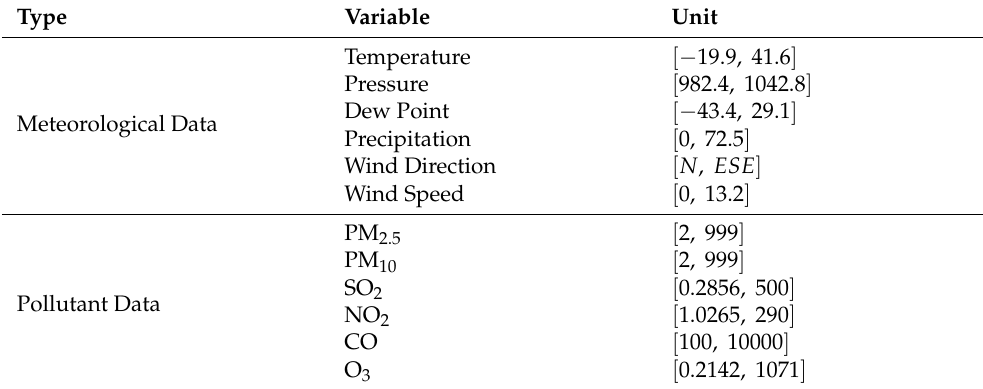
Table 1. Experimental data of the PM 2.5 concentration prediction